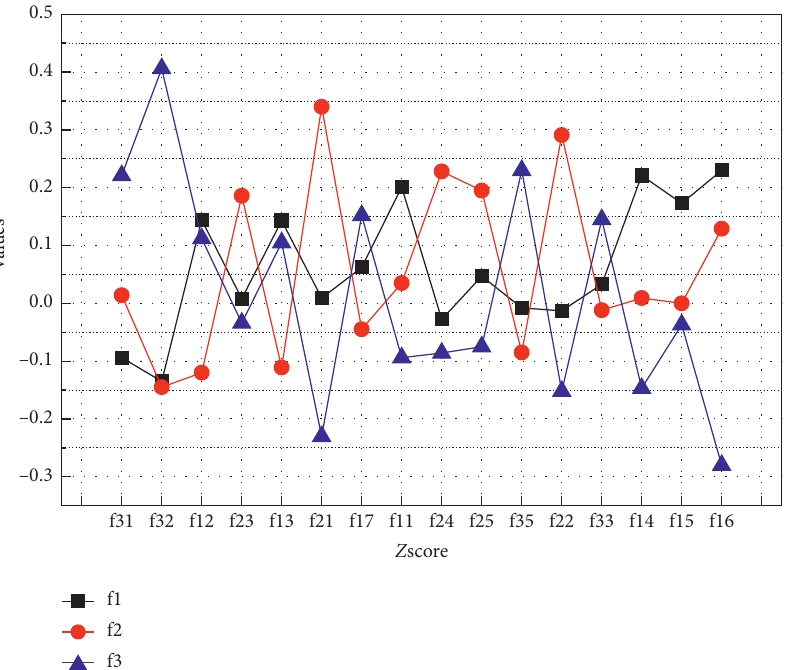
Figure 4: Score coefficient and variance contribution